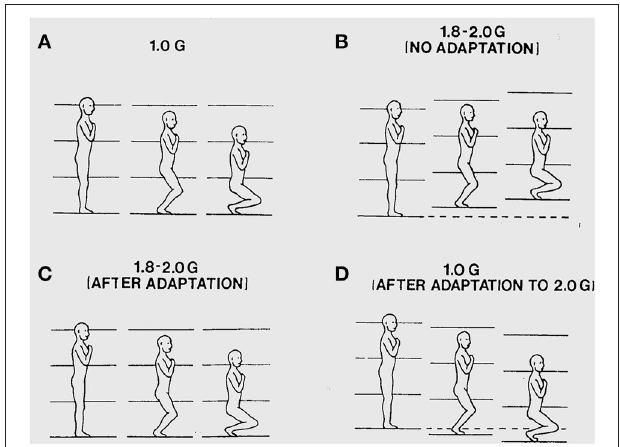
FIGURE 1 | (A) Illustration of a deep knee bend made in 1g. The surface of support and the visual surroundings are felt and seen to remain stationary as the body is lowered. (B) During a deep knee bend made during initial exposure to 1.8g, it feels as if the knees have flexed too rapidly and the aircraft is seen and felt to displace upwards under the feet causing too rapid flexion of the knees. (C) Following about 50 deep knee bends made over subsequent parabolas, the deep knee bends again feel normal and the aircraft is seen and felt to be stable again as the body is lowered. (D) Following adaptation to 1.8g, the initial deep knee bends made during 1g straight-and-level flight again seem abnormal with the body seeming to move downward too slowly because the aircraft seems to move downward slowing the flexing of the